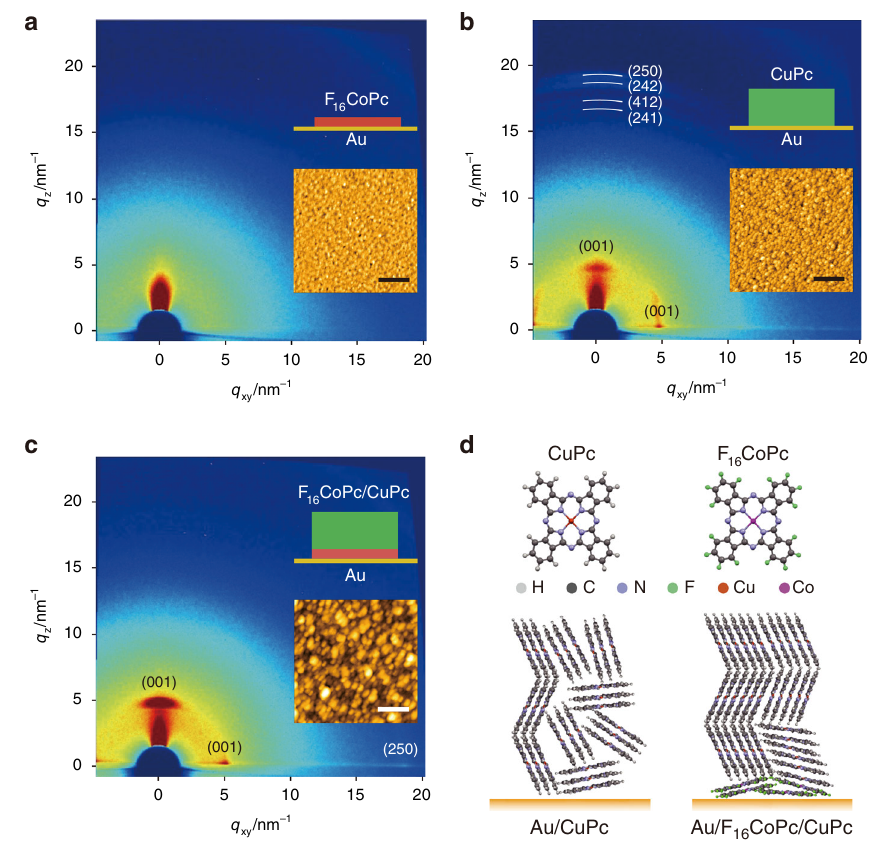
Fig. 1 Structure and morphology of the phthalocyanine molecule layers. a – c 2D-GIXRD patterns of F 16 CoPc (1 nm), CuPc (7 nm), and F 16 CoPc (1 nm)/ CuPc (7 nm), respectively. The corresponding insets present the layer stacks and AFM images (Scale bars, 250 nm). d Schematic molecular packing structures of CuPc grown on bare Au and 1 nm F 16 CoPc coated At the same time, according to the evolution of Φ shown in Fig. 2c, the energy levels of F 16 CoPc bend down toward the Au/ F 16 CoPc interface, while the energy levels of CuPc bend up toward the F 16 CoPc/CuPc interface. In theory, band bending is caused by the charge transfer at the heterojunction 24 . The n-type F 16 CoPc downward band bending toward the metal – semiconductor interface indicates the electron transfer from the Au to the F 16 CoPc resulting in an ohmic contact to the molecules because of a charge reservoir residing in the region of the contact 25 . When we attempted to determine the HOMO edges of the ultrathin F 16 CoPc layers, as shown in Supplementary Fig. 2b, the calculated values for the 0.5 and 1.0 nm F 16 CoPc layers are 0.21 and 0.16 eV, respectively, which HOMO of bulk F 16 CoPc is about 1.2 eV 26 . In fact, a typical